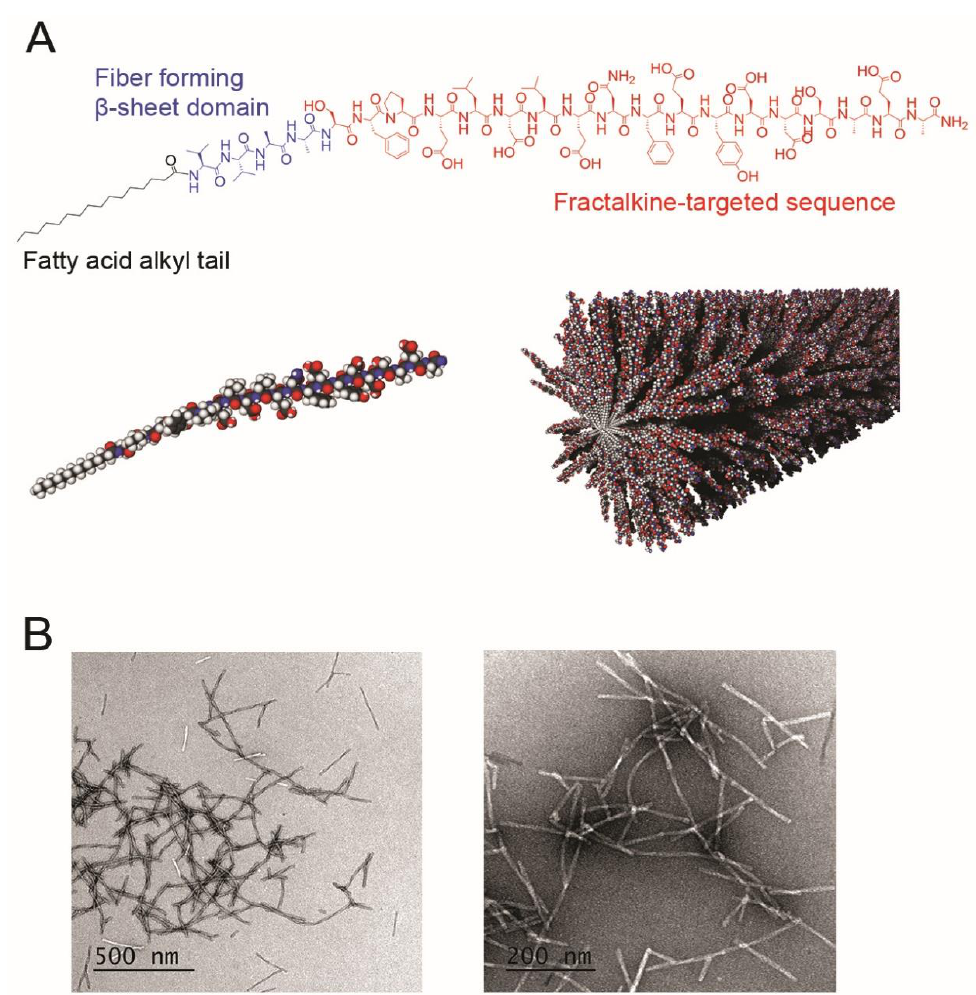
Figure 2. ( A ) Chemical structure of the fractalkine-targeted peptide amphiphile. Red = fractalkine- targeted amino acid sequence, blue = beta-sheet forming sequence, and black = fatty acid alkyl tail. Three-dimensional modeling of the fractalkine-targeted peptide amphiphile is shown below the chemical structure. ( B ) Conventional transmission electron microscopy (TEM) images of fractalkine- targeted nanofibers in positive (left) and negative (right) birefringent exhibiting nanofiber formation.